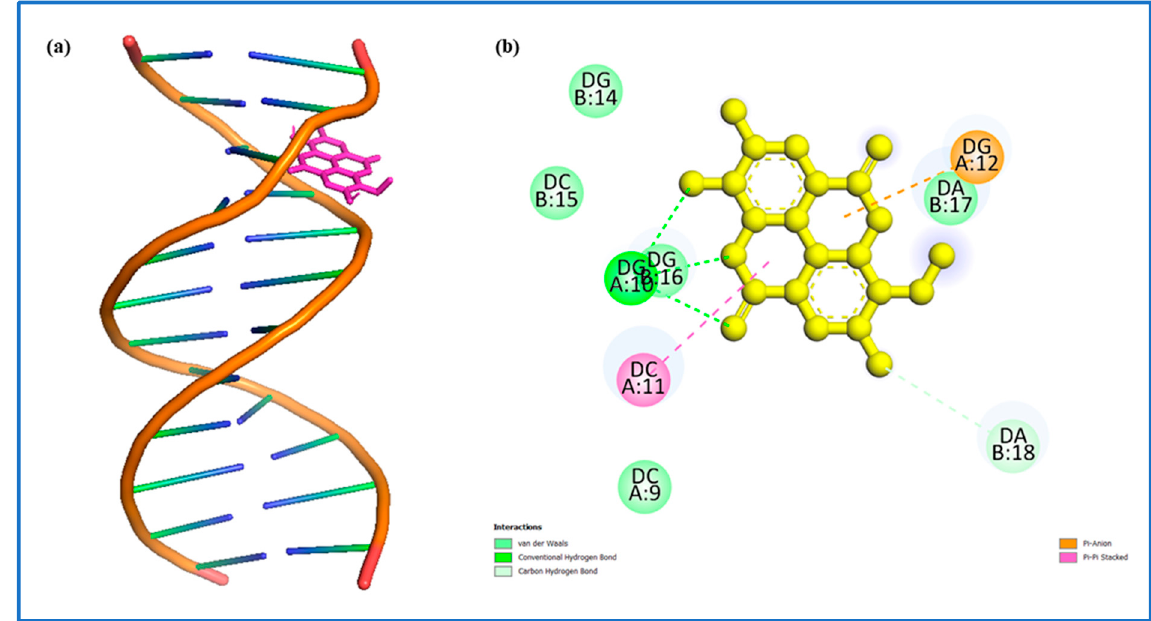
Figure 17. ( a ) Docked pose of compound 2 binding with DNA. ( b ) 2D-plot of the interaction.